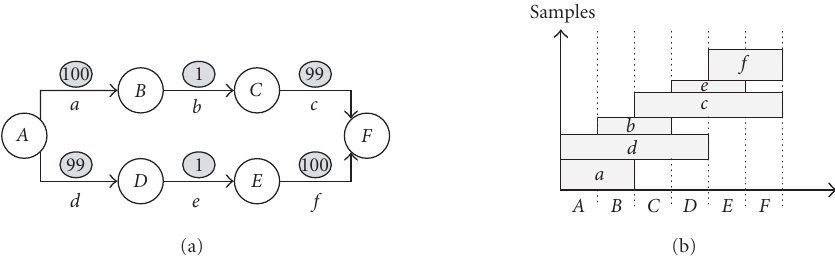
Figure 14: (a) An input graph with samples of di ff erent sizes and (b) a schedule ( = ABCDEF ) and the resultant sample lifetime chart.